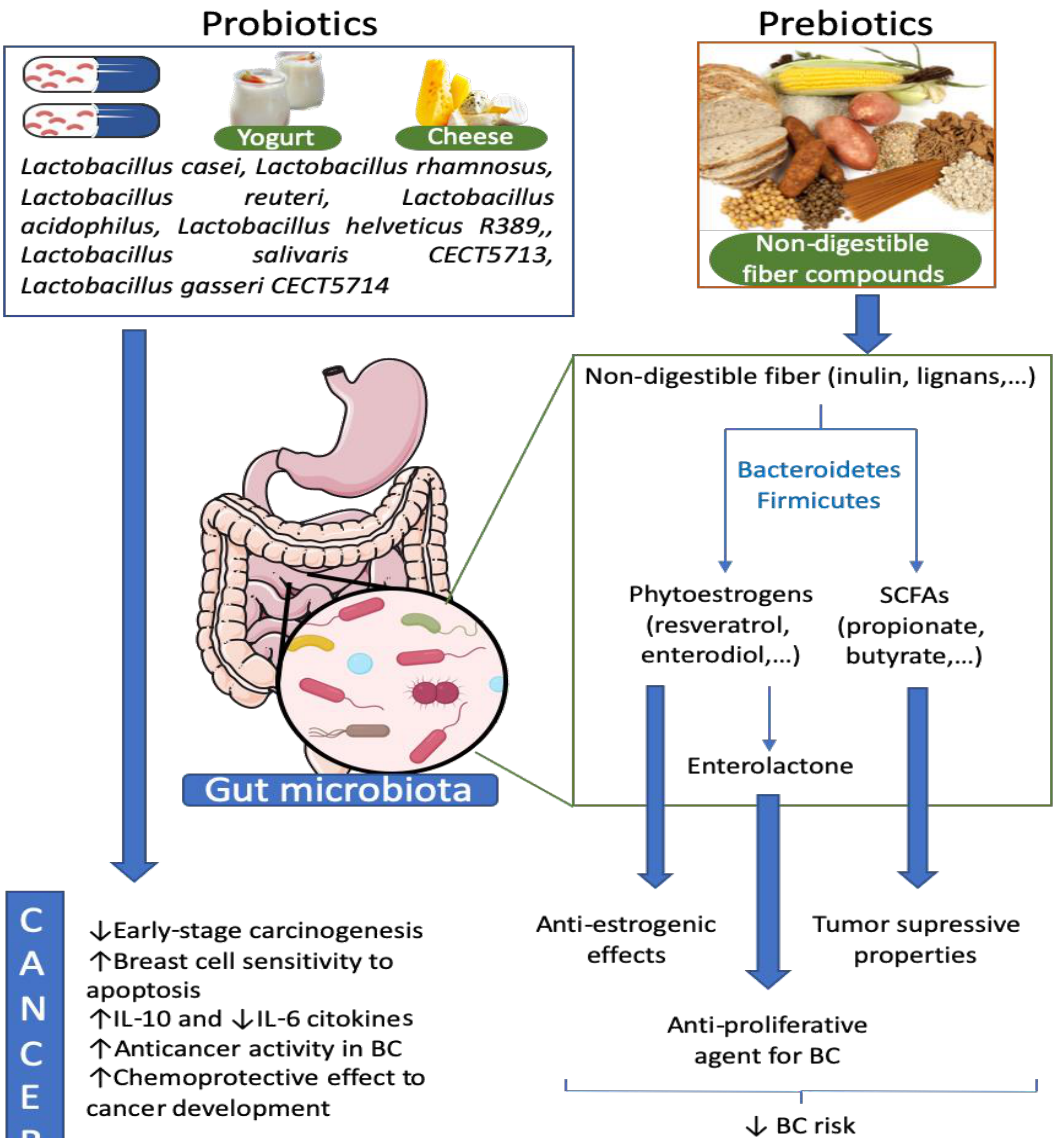
Figure 2. Effect of probiotics and prebiotics on the gut microbiota and BC. Probiotics are living beneficial bacteria, which can restore a dysbiotic microbiota. Some species of Lactobacillus were described to have anticancer activities in BC among other positives effects. On the other hand, prebiotics are normally non-digestible fibers that enhance the proliferation of beneficial bacteria in the gut. Non-digestible fibers can be converted to phytoestrogens and SCFAs by some bacteria belonging to Bacteroidetes and Firmicutes phyla. These bacteria-derived metabolites, as well as other derivates, have tumor suppressor properties and anti-estrogenic and anti-proliferative effects that reduce BC risk.